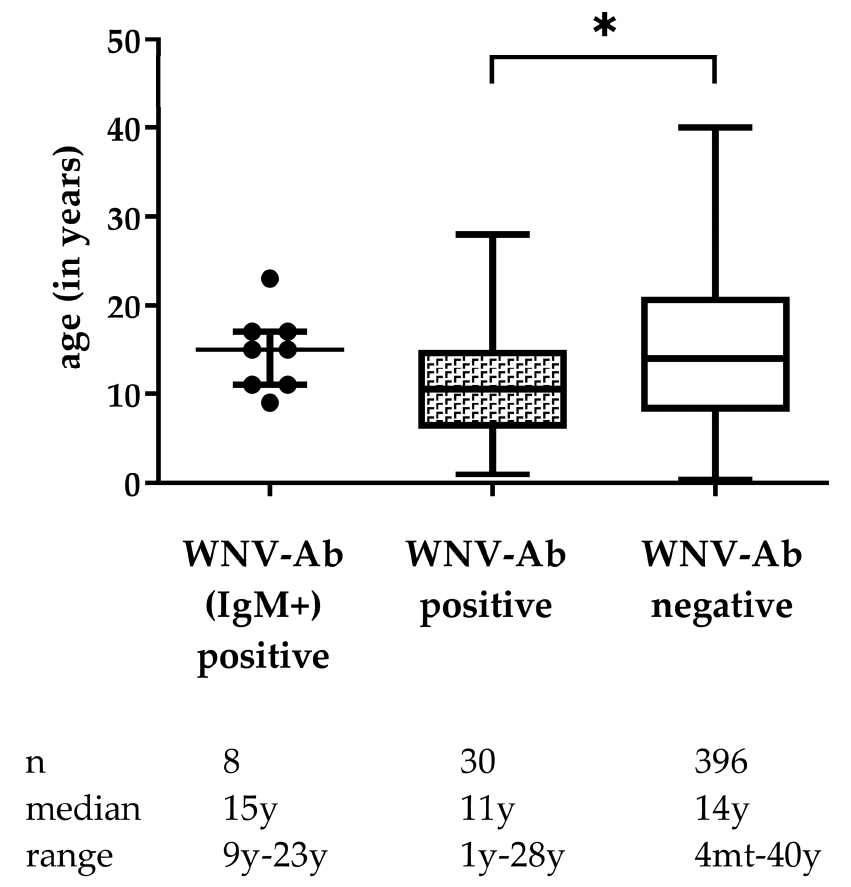
Figure 3. Box plots (median and range) showing the distribution of age in horses that were positive for both IgM and WNV antibodies (Ab (comp. ELISA and VNT positive) n = 8, positive for WNV Ab only (comp. ELISA and VNT positive) n = 30 and negative for WNV Ab (comp. ELISA negative) n = 396 in all horses sampled., for 3 horses the age had not been reported. *, p < 0.05, mt, months, y, years .